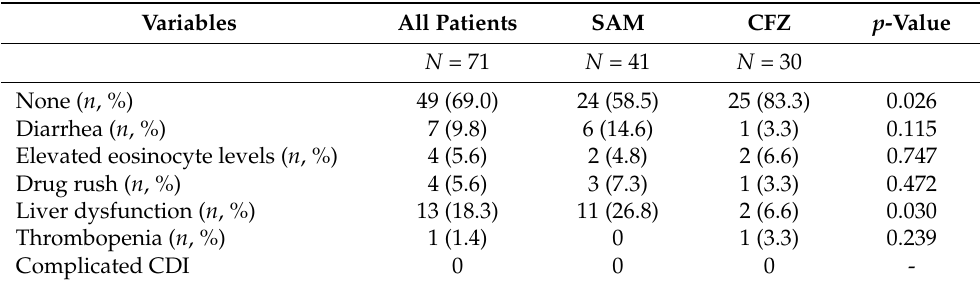
Table 3. Associated side effects of SAM or